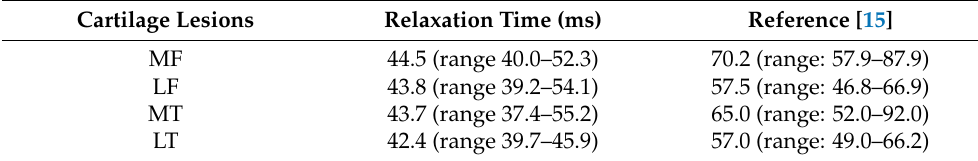
Table 5. Results of cartilage MRI T2 relaxation time. Cartilage